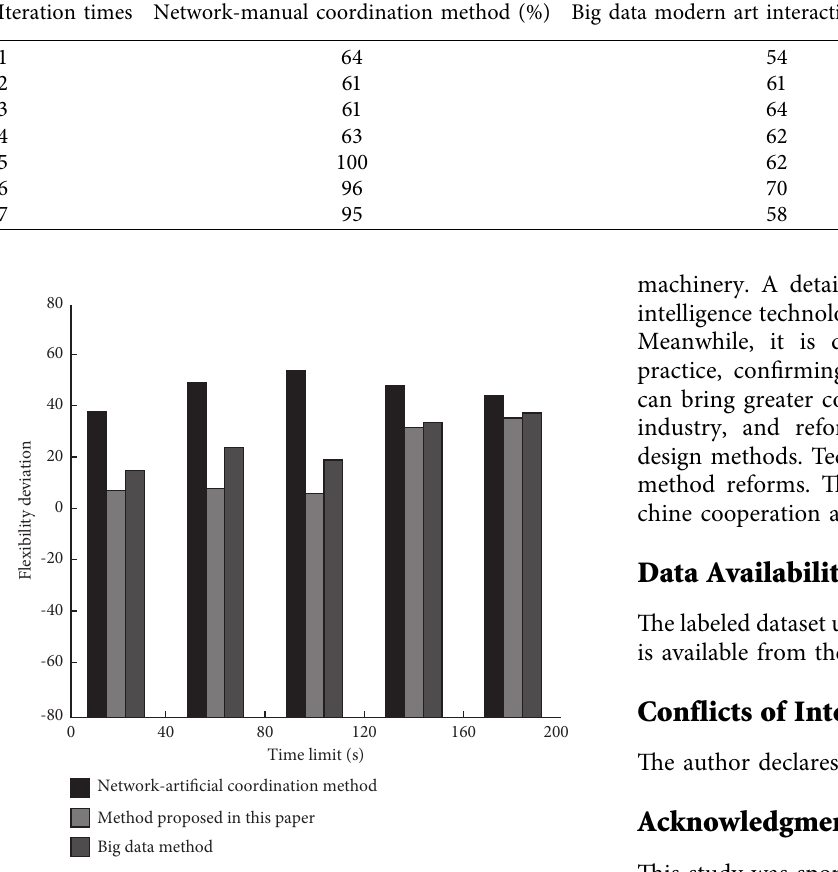
Figure 9: Comparison diagram of the flexibility of interactive